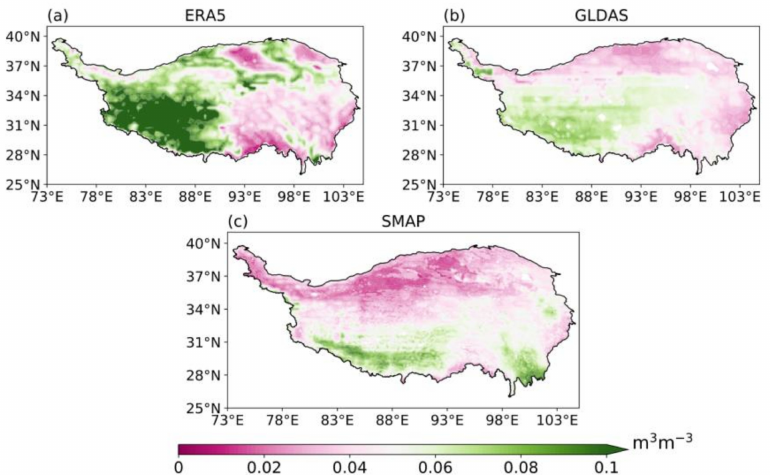
Figure 10. Spatial distribution of the standard deviation of daily soil moisture for May, June, July, and August derived from ( a ) the fifth-generation European Centre for Medium-Range Weather Forecasts atmospheric reanalysis (ERA5), ( b ) Global Land Data Assimilation System (GLDAS), and ( c ) Soil Moisture Active Passive (SMAP)